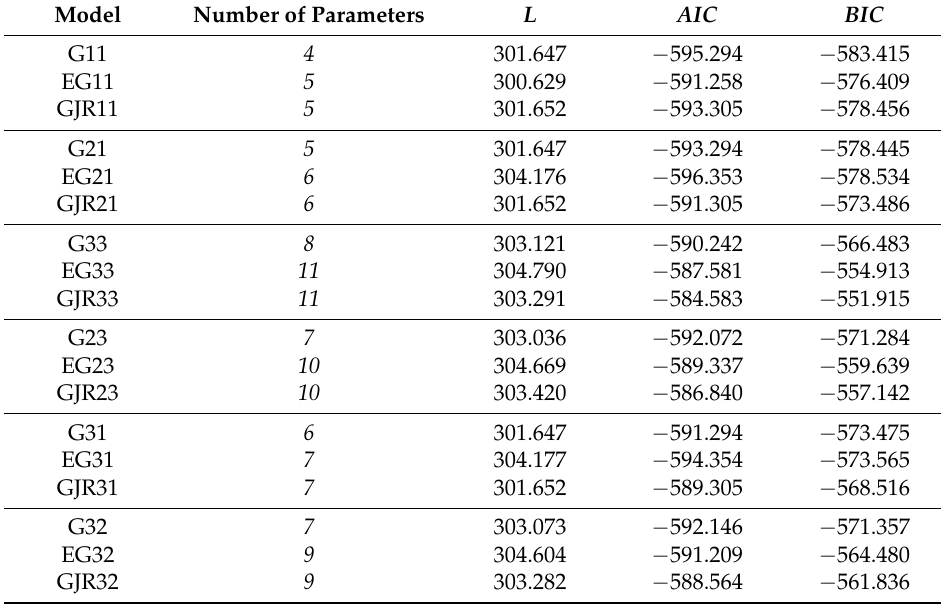
Table 1. Model selection